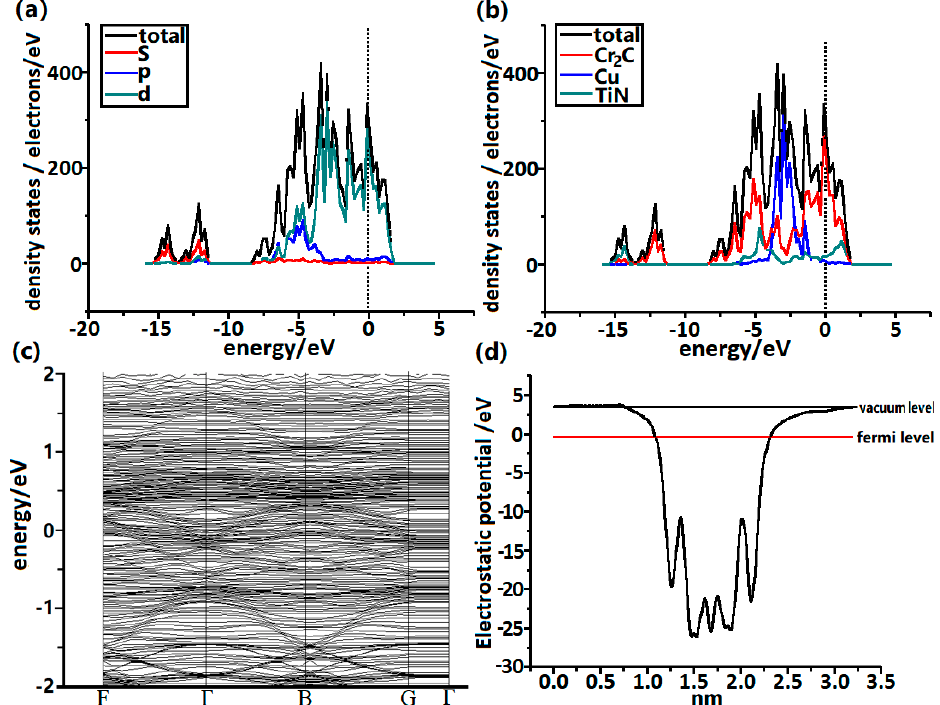
Figure 3. ( a ) Total density of states (TDOS) of Cu/Cr 2 C/TiN and partial density of states (PDOS) for s , p , and d orbitals. ( b ) TDOS of Cu/Cr 2 C/TiN and PDOS for Cr 2 C, Cu, and TiN. ( c ) Band structure of Cu/Cr 2 C/TiN. ( d ) Average static potential along Z-axis.